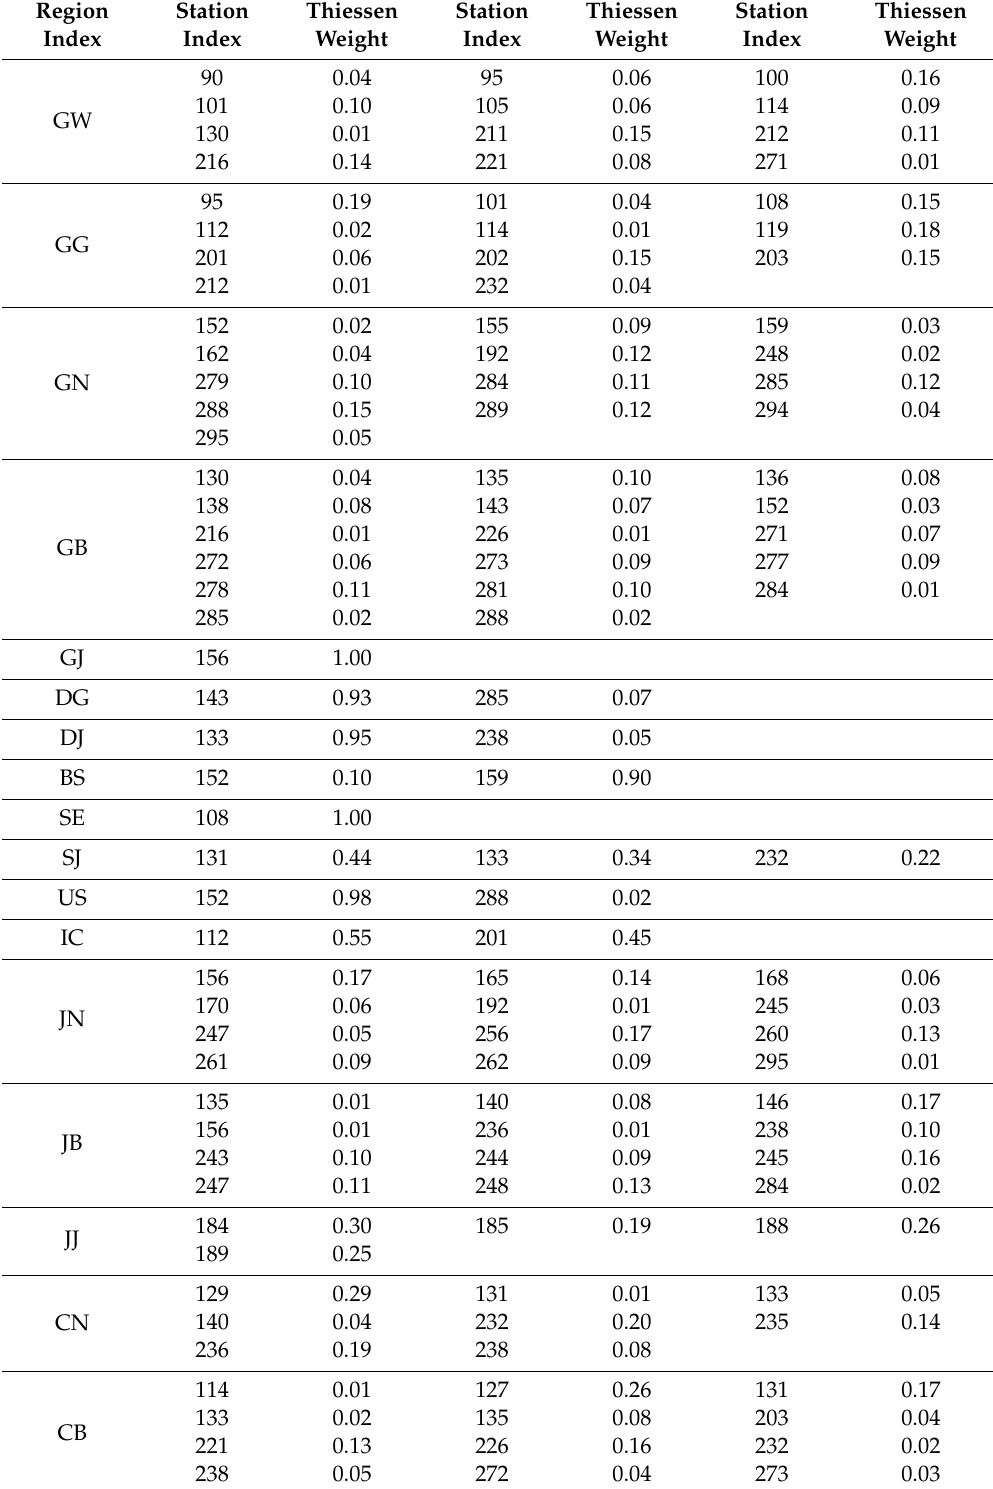
Table A2. Thiessen weight of rainfall observation stations for municipality.